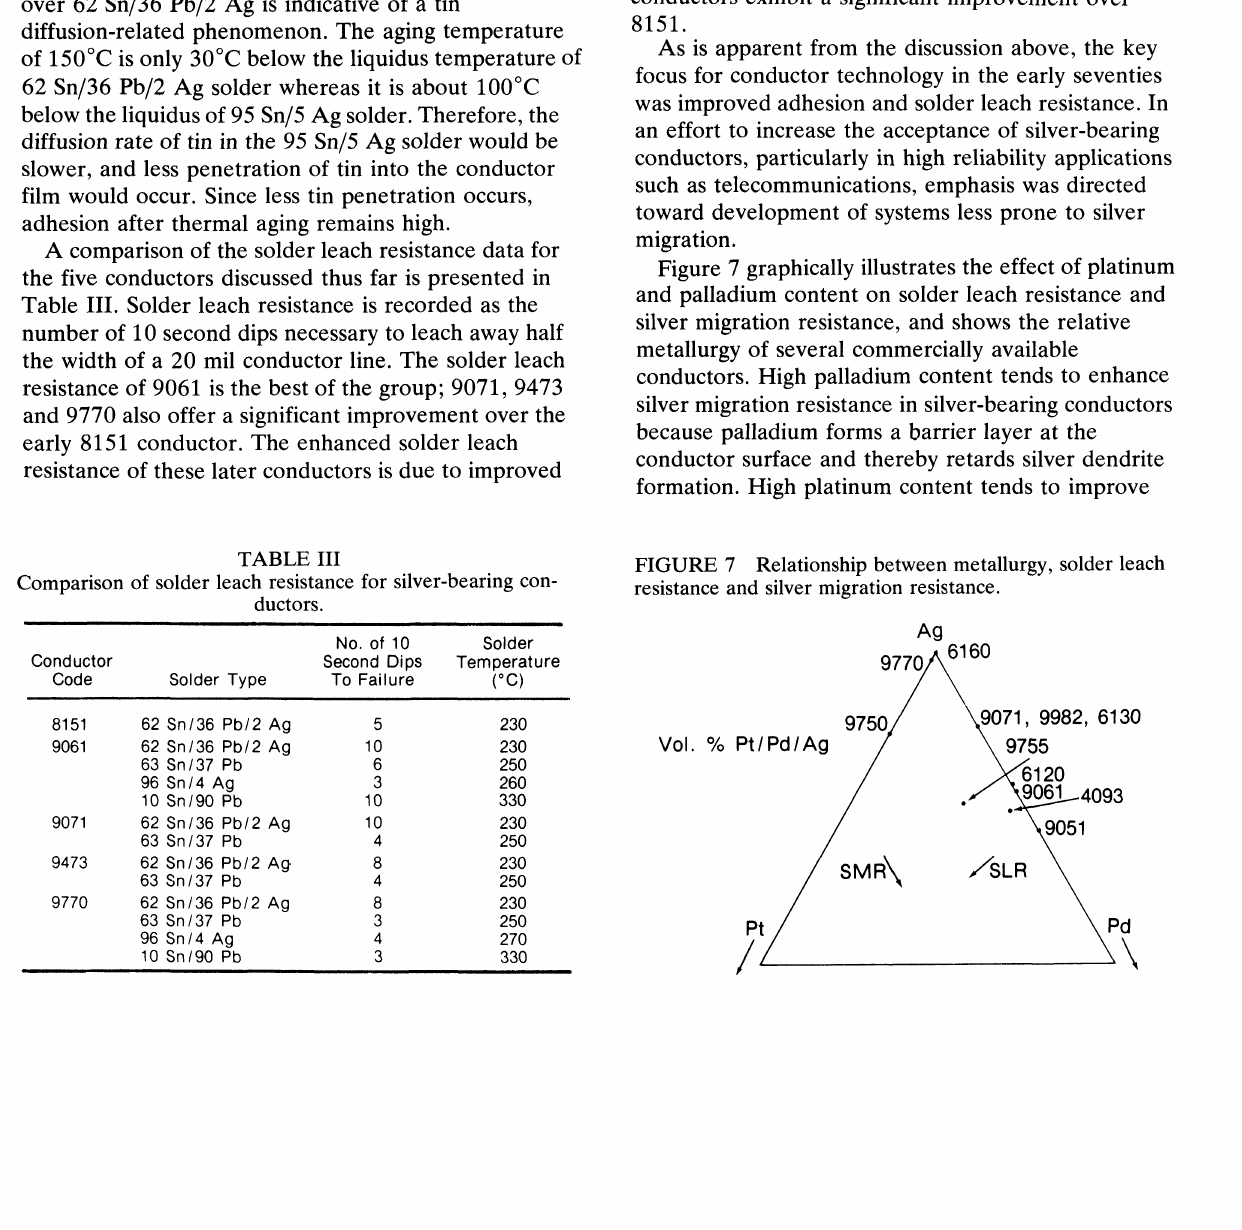
FIGURE 6 Aged adhesion vs. aging time for 9061 Pd/Ag.